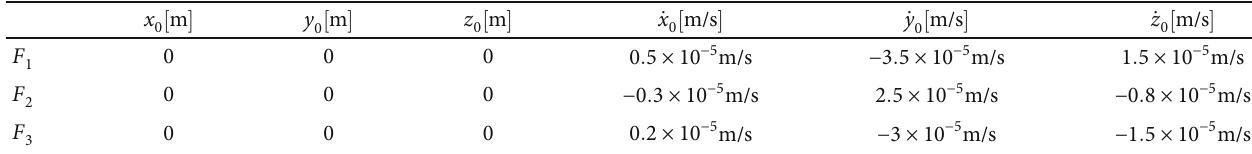
Table 2: Initial position and velocity of the followers in the rotation coordinate